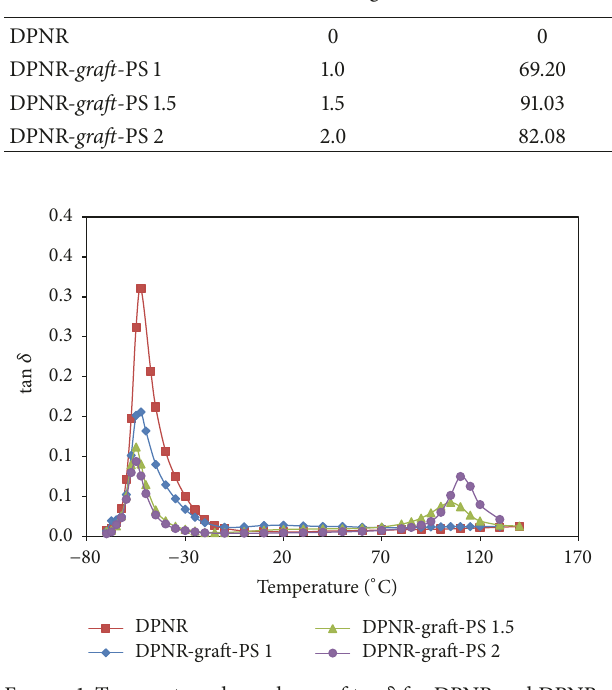
Figure 1: Temperature dependence of tan 𝛿 for DPNR and DPNR- graft-PS samples at 10Hz. Figure 2: Temperature dependence of loss modulus for DPNR and DPNR- graft -PS at 10Hz.